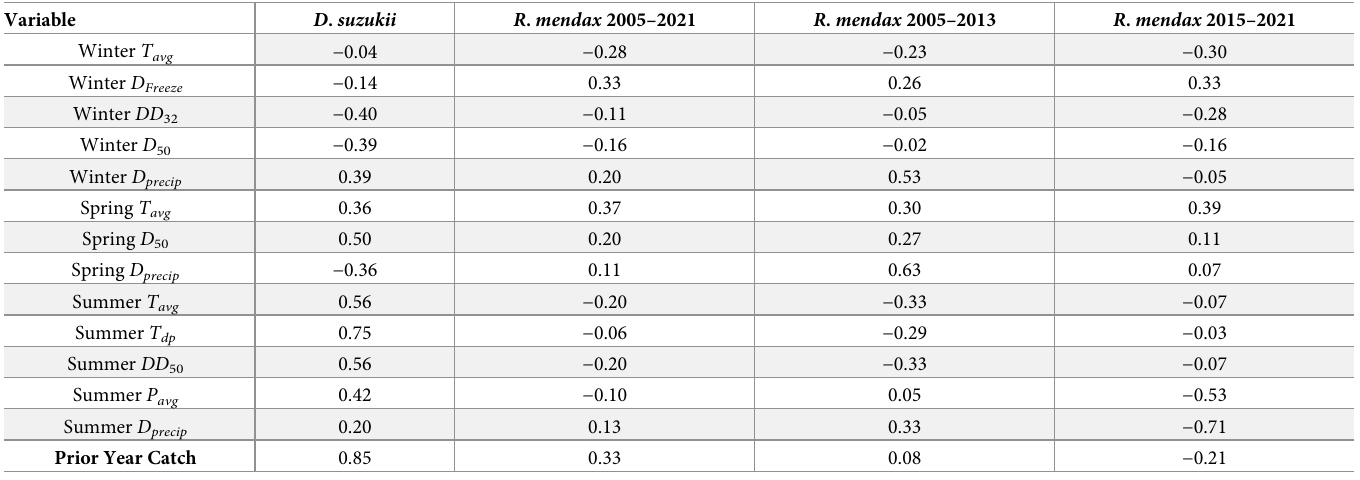
Table 3. Selected Pearson correlation coefficients ( r ) of Rhagoletis mendax annual maximum capture number and Drosophila suzukii average midseason capture number with seasonal climate variables. Three time periods are presented for R . mendax to correspond to before and after D . suzukii invasion and across the entire time period.